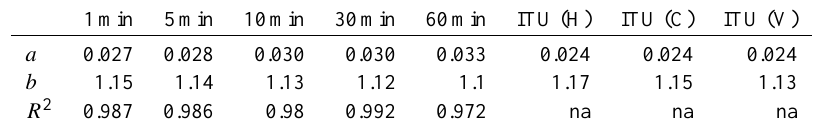
Table 2. Coefficients of linear regression and coefficients of determination obtained by performing linear regressions on log( k ) and log( R ) scatterplots at a frequency f equal to 12GHz and for integration times varying between 1 and 60min. The last three columns indicate the ITU recommendation coefficients corresponding to horizontal, circular and vertical polarizations, respectively, at the same frequency.